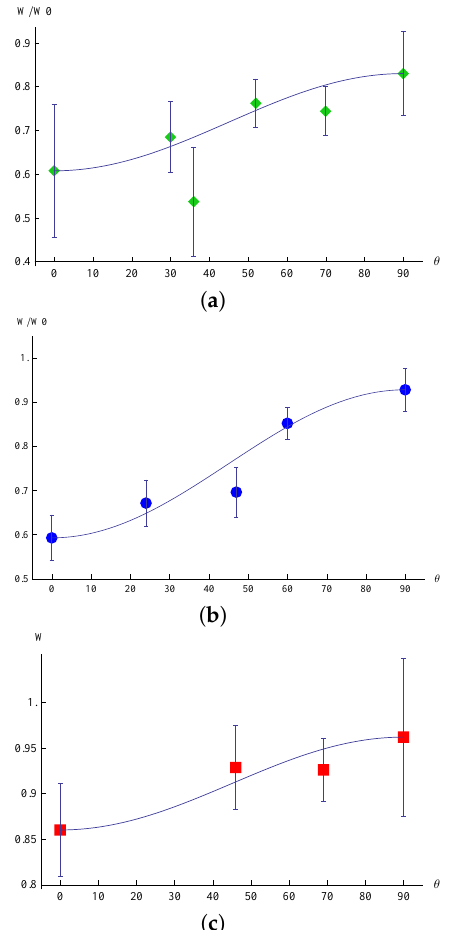
Figure 3. Normalized speed vs. angle of the applied field, experimental measurements and model interpolation as in Equation (11): ( a ) EFH-1 fluid and magnet B; ( b ) EFH-1 fluid and magnet B; ( b ) EFH-1 fluid and magnet C; ( c ) P2XD fluid and magnet C; the value for each configuration is the mean over several repeated “ball-drop” trials in that configuration; the error bars are the standard-deviation from the mean value for the repeated trials in a given